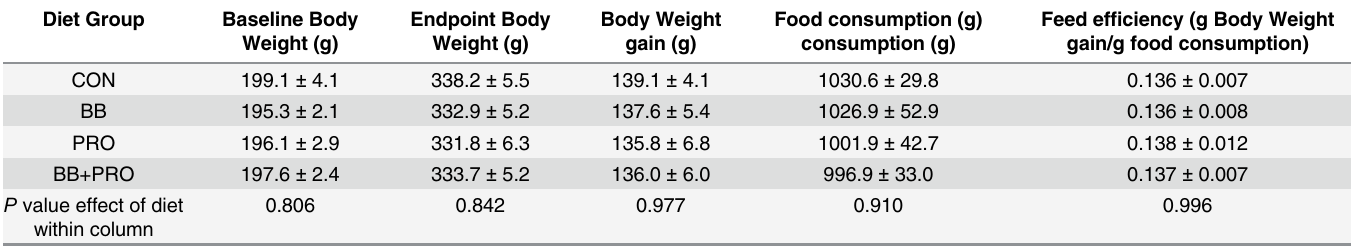
Table 2. Body weight and food